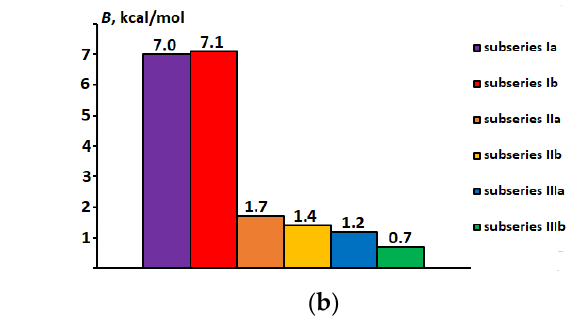
Figure 7. Dependence of the − E π (PPE) values on the σ p Hammett constants for subseries Ia,b with the double bond as the π‐ bridge ( a ), subseries IIa,b with the para ‐ phenyl ring as the π‐ bridge ( b ) and subseries IIIa,b with the meta ‐ phenyl ring as the π‐ bridge ( c ).